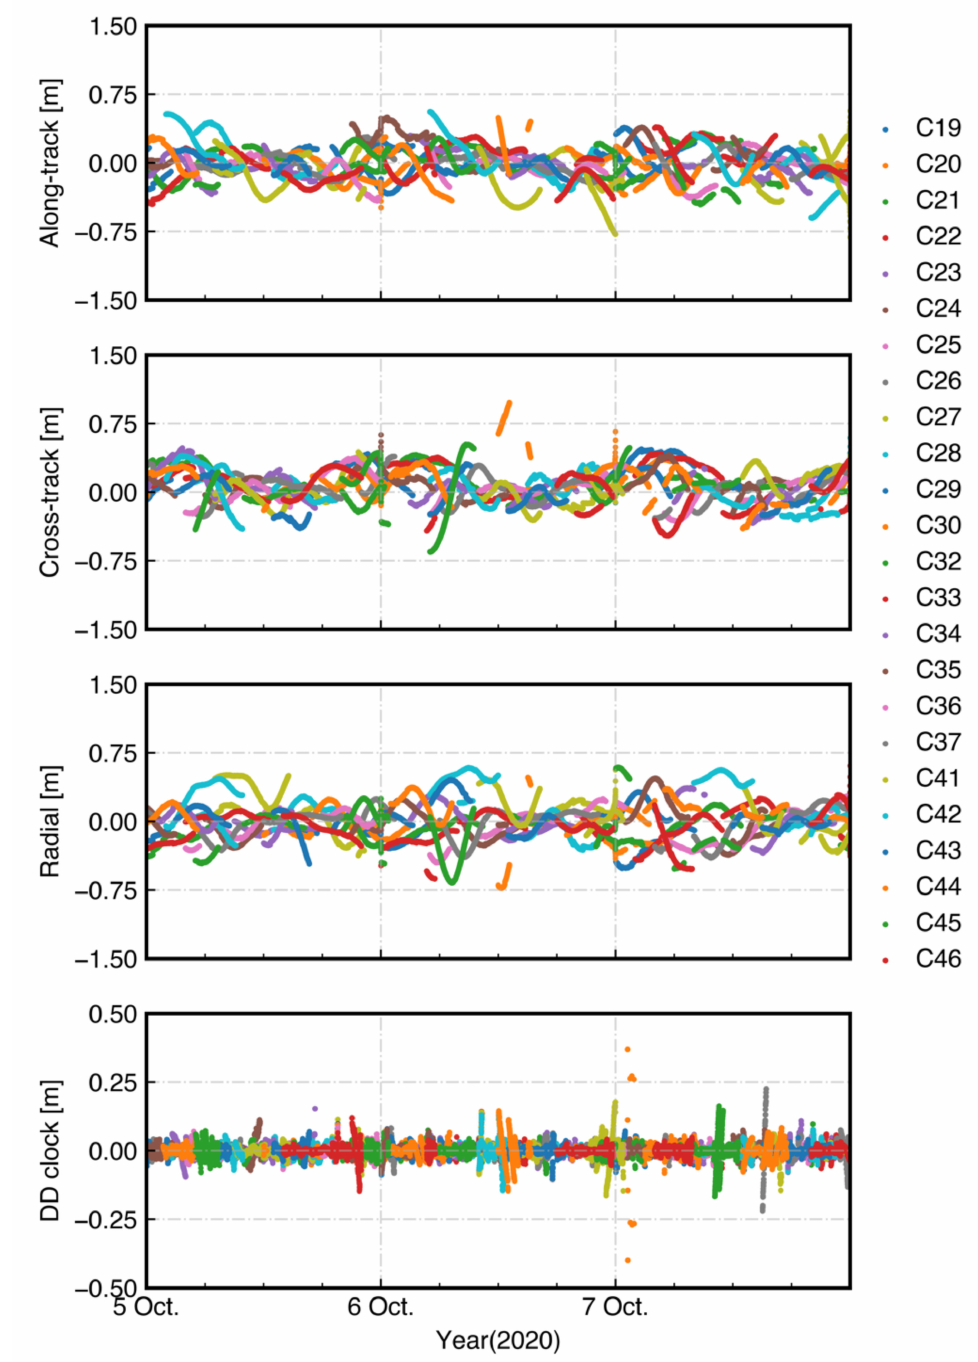
Figure 4. BDS PPP-B2b orbit and clock errors from 5 October 2020 to 7 October 2020. The root mean square (RMS) of PPP-B2b orbit errors was counted to assess the preci- sion of PPP-B2b precise orbit corrections. Considering that a common constant of clock offset errors can be absorbed into the receiver clock offset parameter, the standard devia- tion (STD) of PPP-B2b precise clock offset errors was adopted to evaluate the precision of PPP-B2b clock offset corrections. Figures 5 and 6 show the RMS values of PPP-B2b orbit errors, and the STD value of PPP-B2b clock offset errors over a period of 3 days. Table 3 fur- ther presents the average RMS values of orbit errors in the along-track/cross-track/radial components, and the average STD values of clock offset errors. In general, the